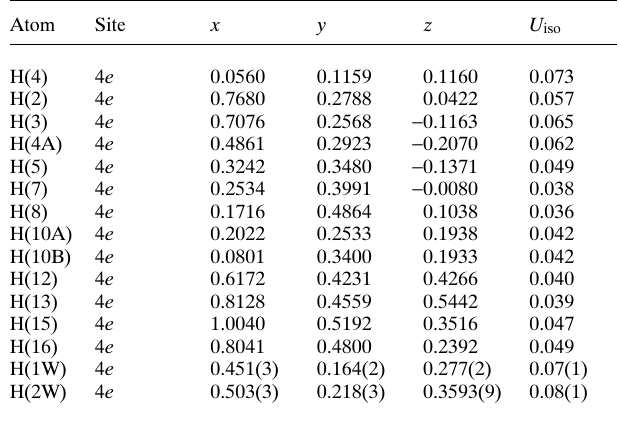
Table 2. Atomic coordinates and displacement parameters (in Å 2 ) .